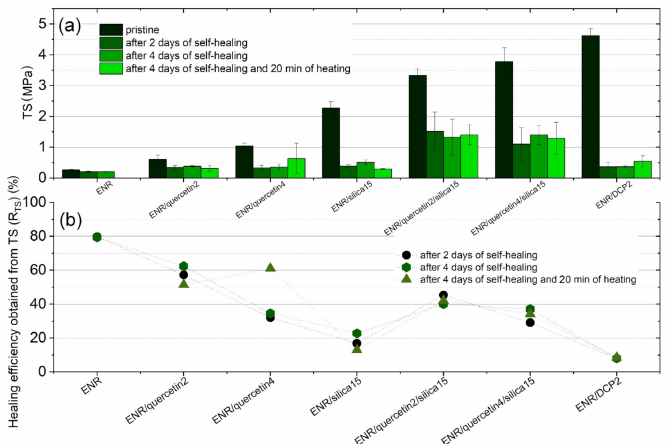
Figure 4. Tensile strength (TS) of tested materials before and after the self-healing process ( a ) and healing efficiency calculated using TS results for every material after 2 days, 4 days and 4 days with 20 min of heating ( b